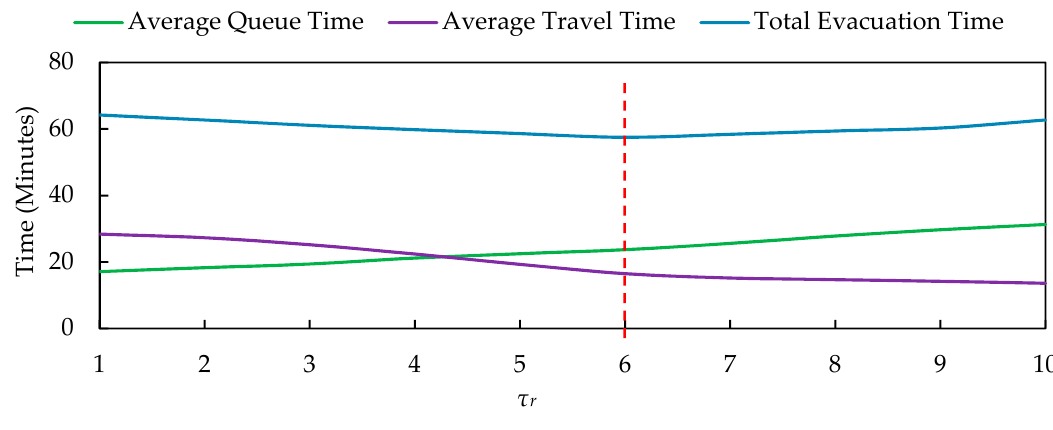
Figure 9. Sensitivity analysis of τ r .